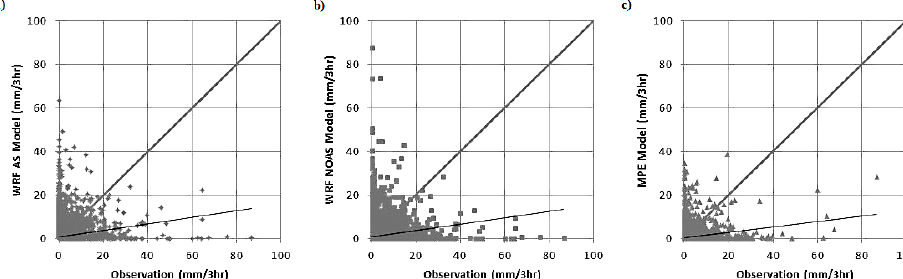
Fig. 5. Scatter diagrams of all data at 3h intervals are shown in (a) between WRF with assimilation and observation, (b) between WRF without assimilation and observation, and (c) between MPE and